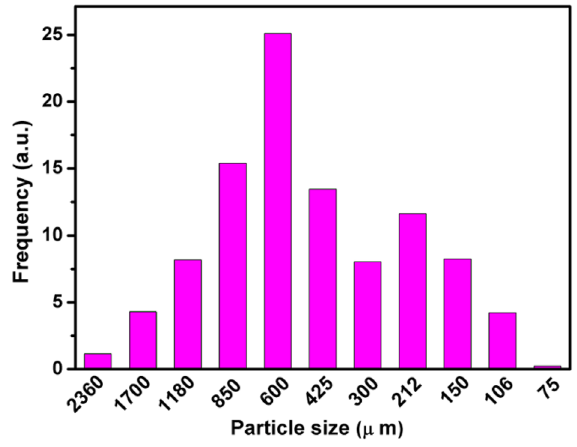
Figure 6. Histogram for particle size of the grinded Cassia tora L. seeds meal.